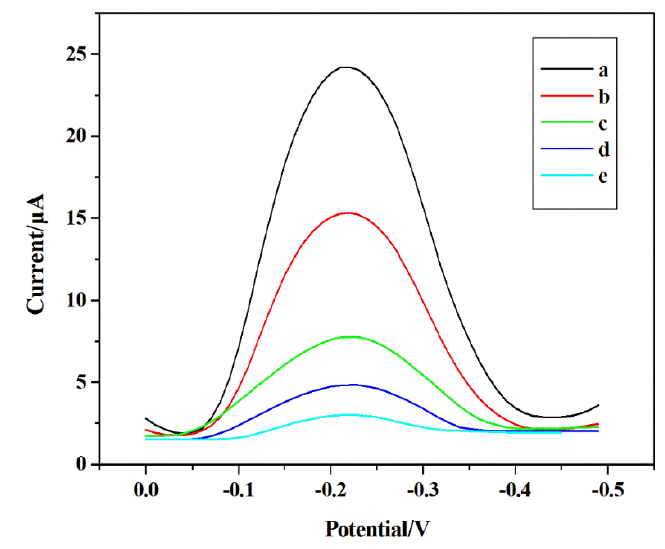
Figure 3. Schematic diagram of response current DPV of (a) Determination of UO 22+ after elu- tionrecombination of MIIP/Fe 3 O 4 @SiO 2 /MCPE in 1.5 × 10 − 7 mol L − 1 UO 22+ solution for 20 min, (b) Determination of UO 22+ by MIIP/Fe 3 O 4 @SiO 2 /MCPE with template, (c) Determination of UO 22+ by N-MIIP/Fe 3 O 4 @SiO 2 /MCPE, (d) Determination of UO 22+ by MCPE, (e) Determination of UO 22+ by MIIP/Fe 3 O 4 @SiO 2 /MCPE after eluting the